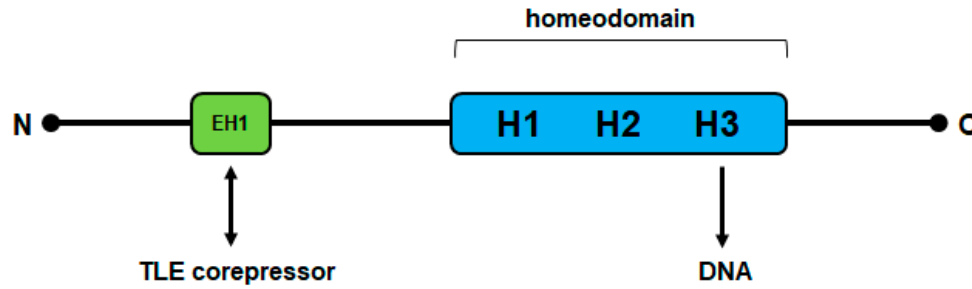
Figure 1. Schematic structure of NKL homeodomain proteins. N: N-terminal end; C: C-terminal end; EH1: conserved engrailed homology domain consisting of about 8 amino acid residues (shown in green); the conserved homeodomain consists of 60 amino acid residues which generate three helices (H1, H2, H3) and is shown in blue; the N- and C-terminal parts show no sequence conservation. The EH1 domain and the homeodomain interact with particular components of the gene regulatory machinery including corepressors of the TLE family and specific DNA sequences, respectively.